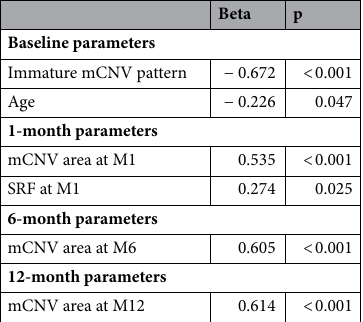
Table 7. Results of multivariate regression analysis for Subretinal Fibrosis occurrence at 12 months as dependent variables. BCVA Best-Corrected Visual Acuity, mCNV myopic choroidal neovascularization, M1 1-month examination, M6 6-month examination, M12 12-month